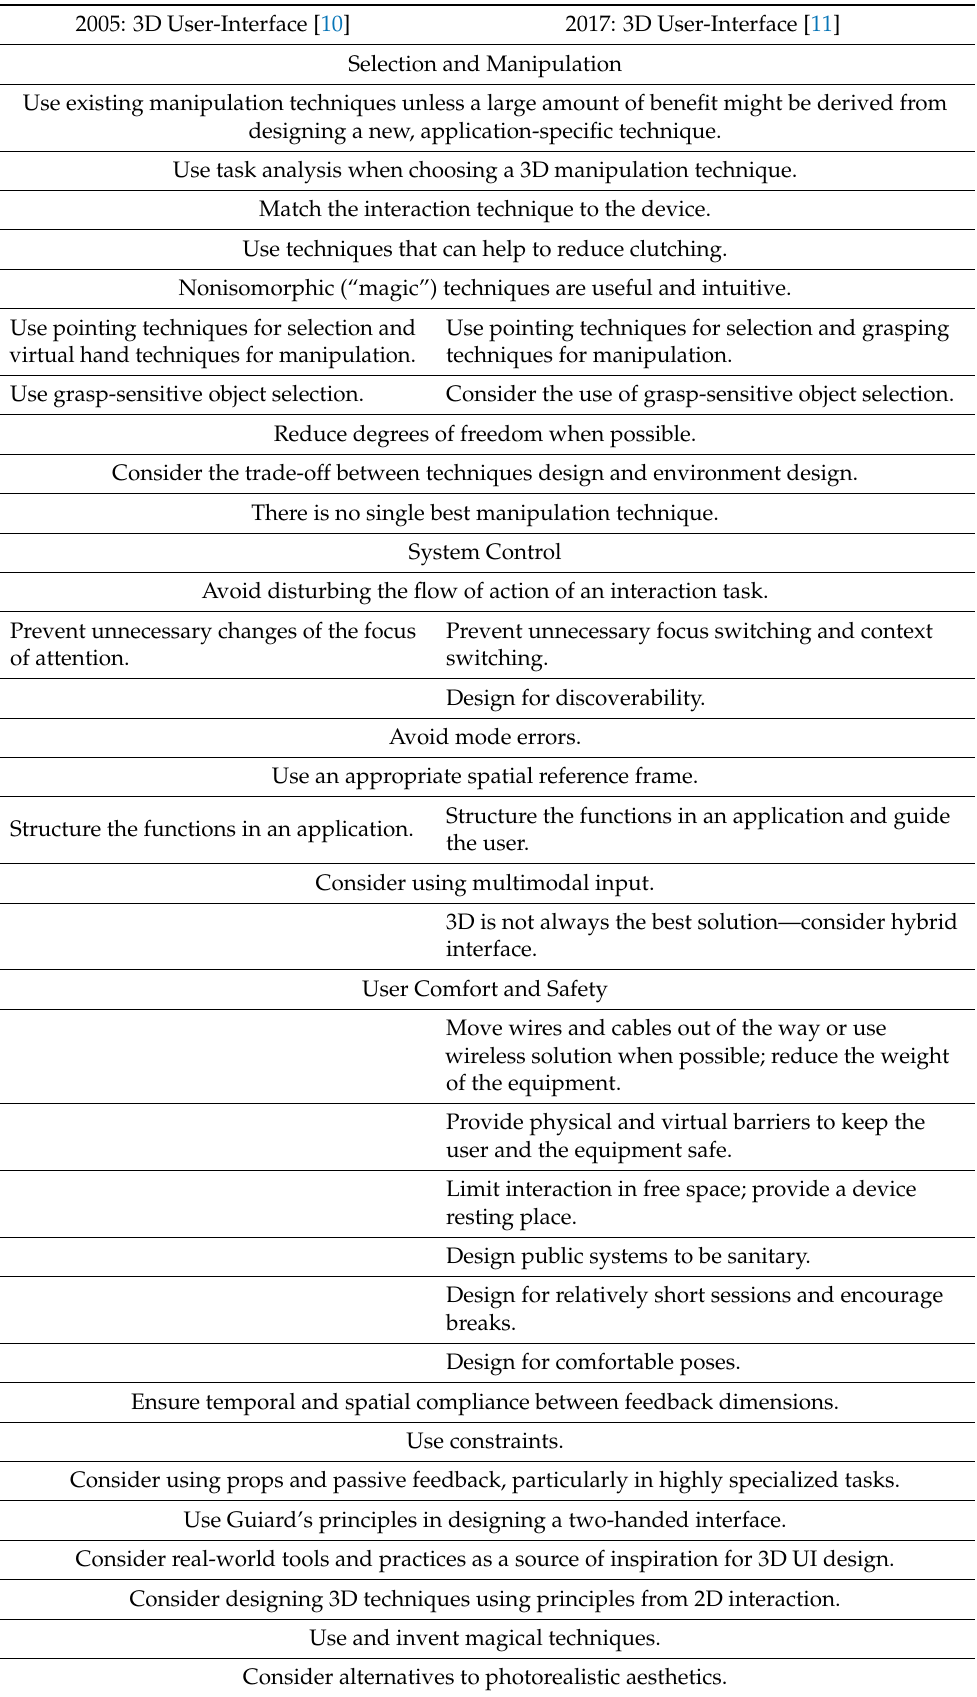
Table 1. Comparison of Bowman and LaViola 2005 and 2017 design